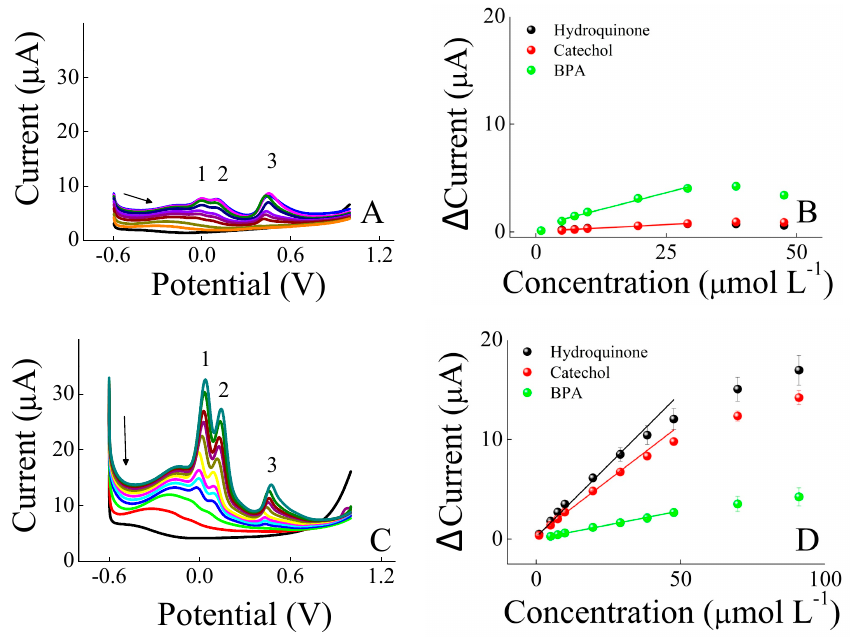
Figure 1. ( A ) Differential Pulse Voltammetry (DPV) data for simultaneous detection of (1) hydroquinone, (2) catechol, and (3) BPA using flexible SPEs before electrochemical pretreatment, ( B ) Calibration curves for SPEs before electrochemical pretreatment, ( C ) Differential Pulse Voltammetry (DPV) data for simultaneous detection of (1) hydroquinone, (2) catechol and (3) BPA using SPEs after electrochemical pretreatment and ( D ) Calibration curves for SPEs after electrochemical pretreatment. Conditions: concentration range from 0.5 to 90 × 10 − 6 mol L − 1 , in phosphate buffer solution 0.1 mol L − 1 , pH 7.0.